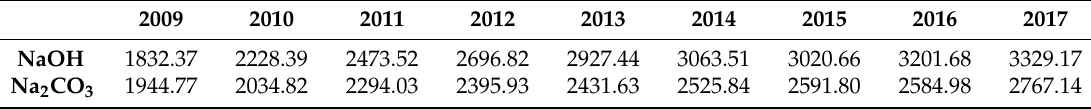
Table 2. The production (10 4 t) of NaOH and Na 2 CO 3 during 2009–2017 in China 1